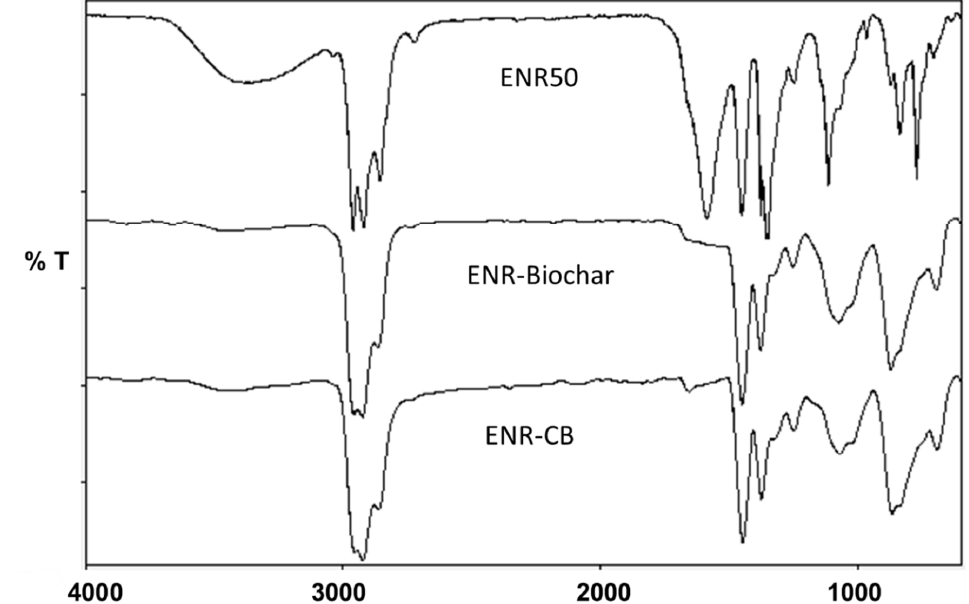
Figure 6. FTIR spectra of ENR 50, ENR-Biochar, ENR-CB at 10phr loading.